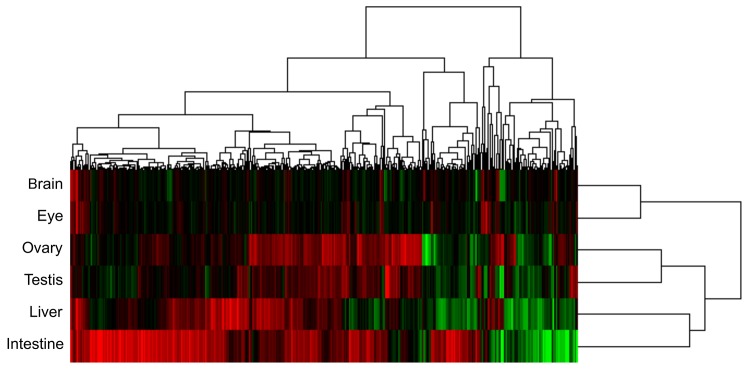
Hierarchical cluster analysis of gene expression levels derived by conditional tree clustering.The top 400 genes ranked by Total Space Responsiveness (||TSR||) were analyzed using Cluster version 3.0. Red and green indicate increases and decreased expression levels of each gene in response to spaceflight, respectively.